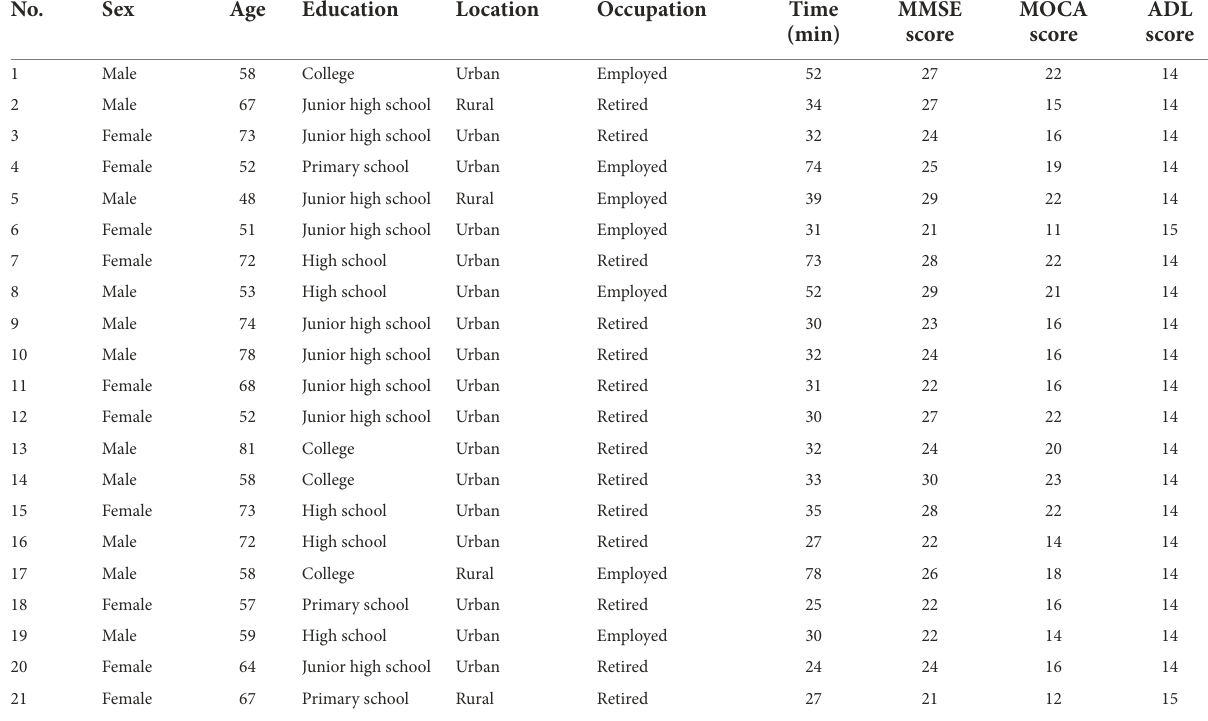
TABLE 2 Patients’ demographic